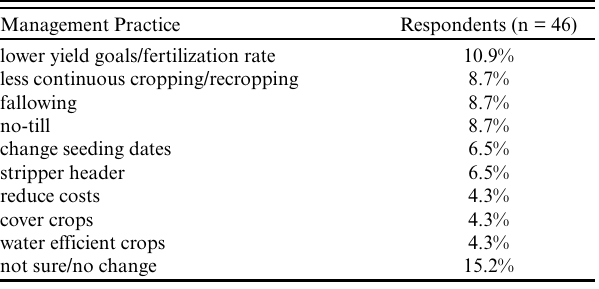
Table 1 . Summary of the management practices farmers reported they would use in response to extended drought (multiple options